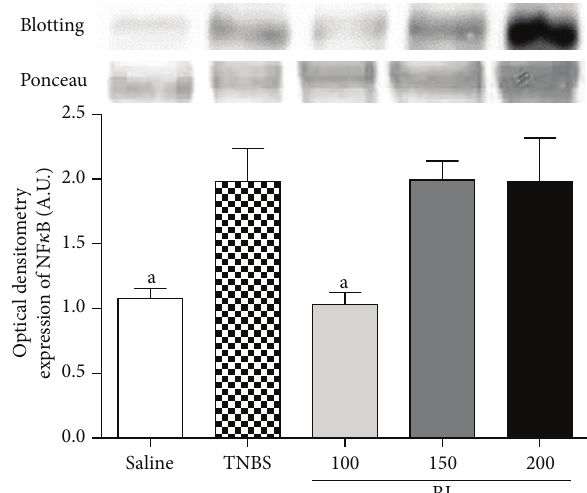
Figure 3: Representative Western blot analysis of analysis of NF- 𝜅 B. Densitometric data were studied following normalization to the control (Ponceau). The results are representative of three experi- ments performed on different samples and data are expressed as mean ± SEM. ANOVA followed by Dunnett’s 𝑡 -test. a 𝑃 < 0.05 is significantly different from TNBS